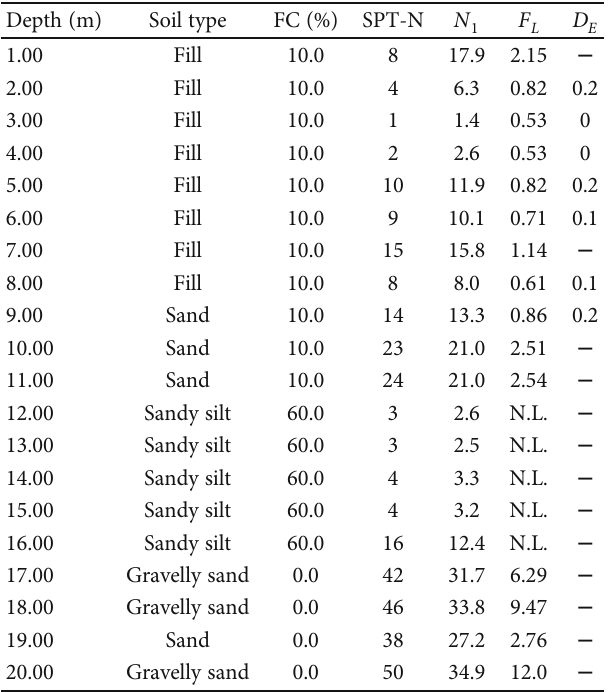
Table 2: Liquefaction potential assessment of the site of case